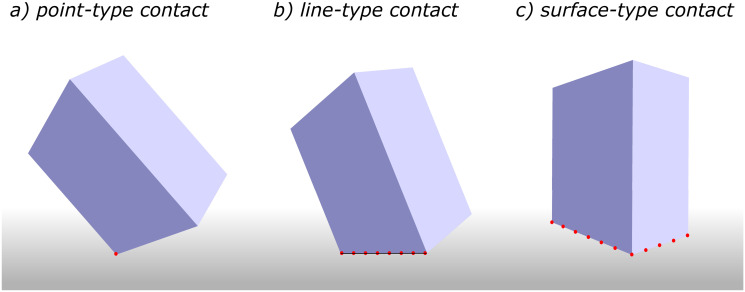
Different types of wall-particle contact.Various scenarios can happen when a particle collides with the wall: (collision points are shown as red dots) (a) point-type contact, (b) line-type contact, and (c) surface-type contact.